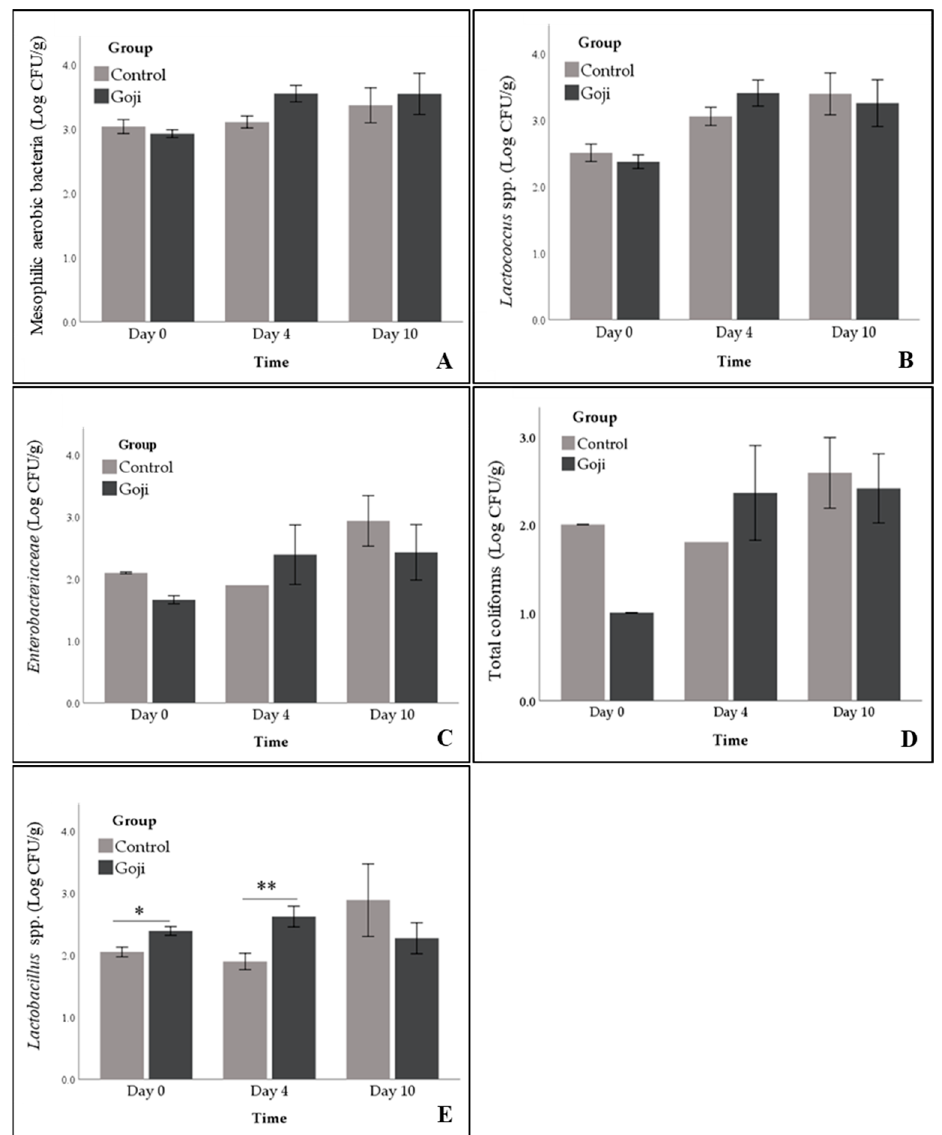
Figure 2. Effects of Goji berries inclusion in the diet of rabbits on counts of mesophilic aerobic bacteria ( A ), Lactococcus spp. ( B ), Enterobacteriaceae ( C ), total coliforms ( D ), and Lactobacillus spp. ( E ) on meat at slaughtering (Day 0), day 4, and 10 of shelf-life. The bar graphs show mean ± standard error. Anomalies in the error bars are due to the low prevalence. *: p < 0.05; **: p <